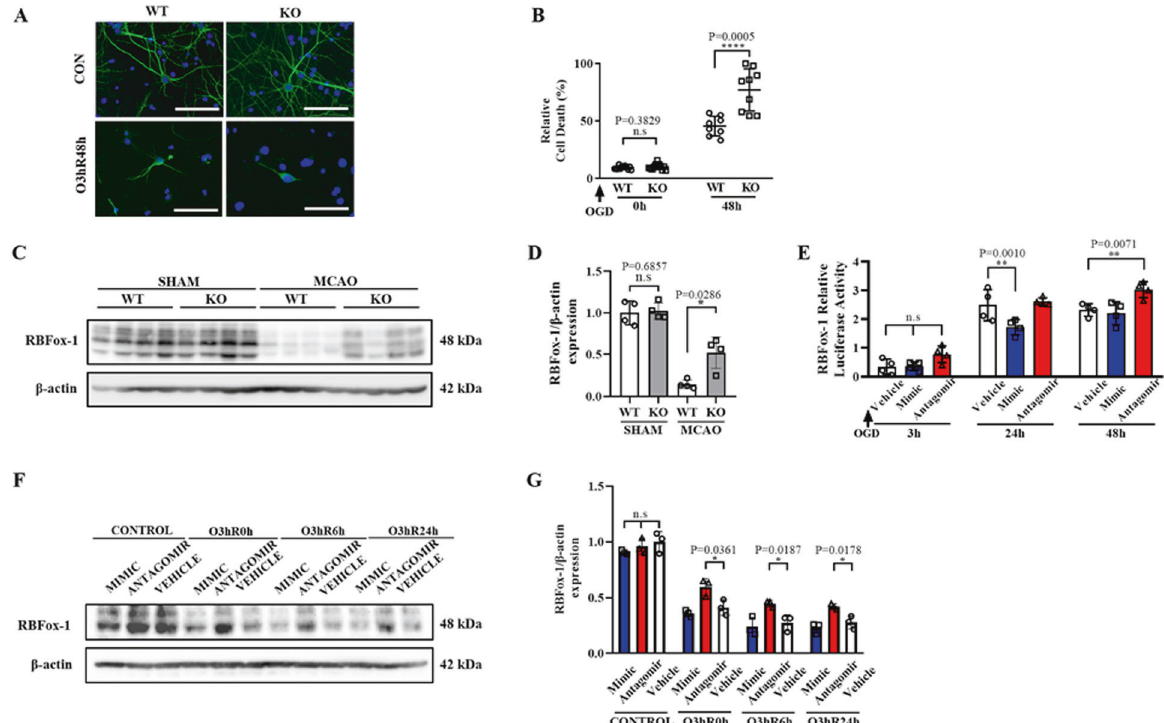
Fig. 4 CRTC1 deletion and miR-132 knockdown aggravate neuron damage. A Representative microtubule-associated protein 2 (MAP2) immunostaining images of CRTC1 KO and WT neurons, before and after OGD. (Scale Bar, 100 μ m). B LDH assay of CRTC1 KO and WT neuron up to 48 h after ischemia/reperfusion. Representative Western Blot images ( C ) and quanti fi cation ( D ) of RBFox-1 in CRTC1 KO and WT mice penumbra region. E Relative luciferase activity of CHO cell line co-transfected with RBFox-1 and miR-132 vehicle/mimic/antagomir. Representative Western Blot images ( F ) and quanti fi cation ( G ) of RBFox-1 in neurons transfected with miR-132 mimic/antagomir/vehicle, before and after